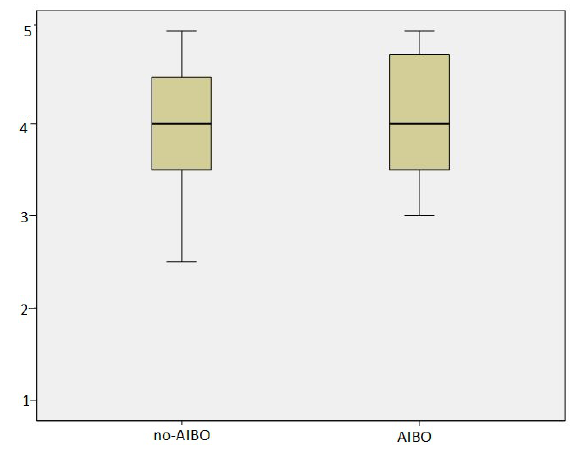
Figure 10. Communication and interaction experience between the users for both no-AIBO and AIBO modes (data extracted from question- naires).